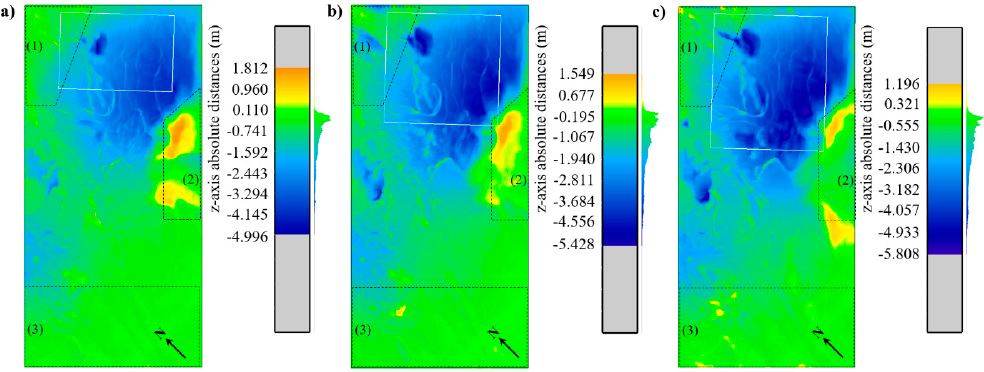
Figure 18. Monitoring data C2C comparison along z-axis: ( a ) Epoch 0–4, ( b ) Epoch 0–5, ( c ) Epoch 0–6.